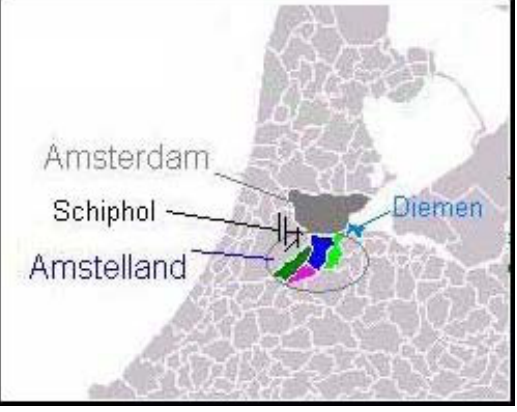
Figure 1. Map of west of the Netherlands with survey area and airport.